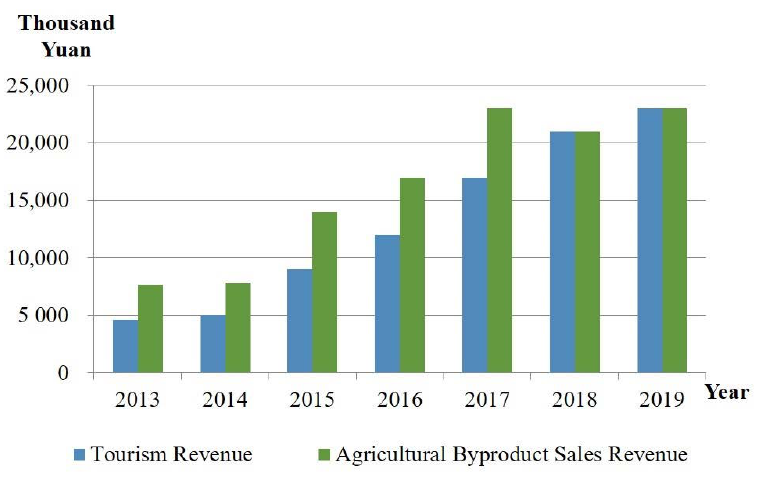
Figure 10. Revenues of tourism and agricultural byproduct sales in Baiyankeng village (2013–2019) (data provided by the village committee).